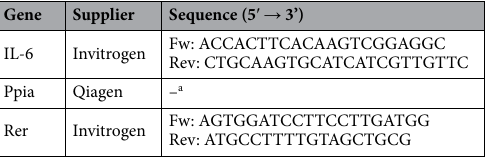
Table 5. Primers for BV-2 qPCR. a Sequence of the primers is not disclosed by